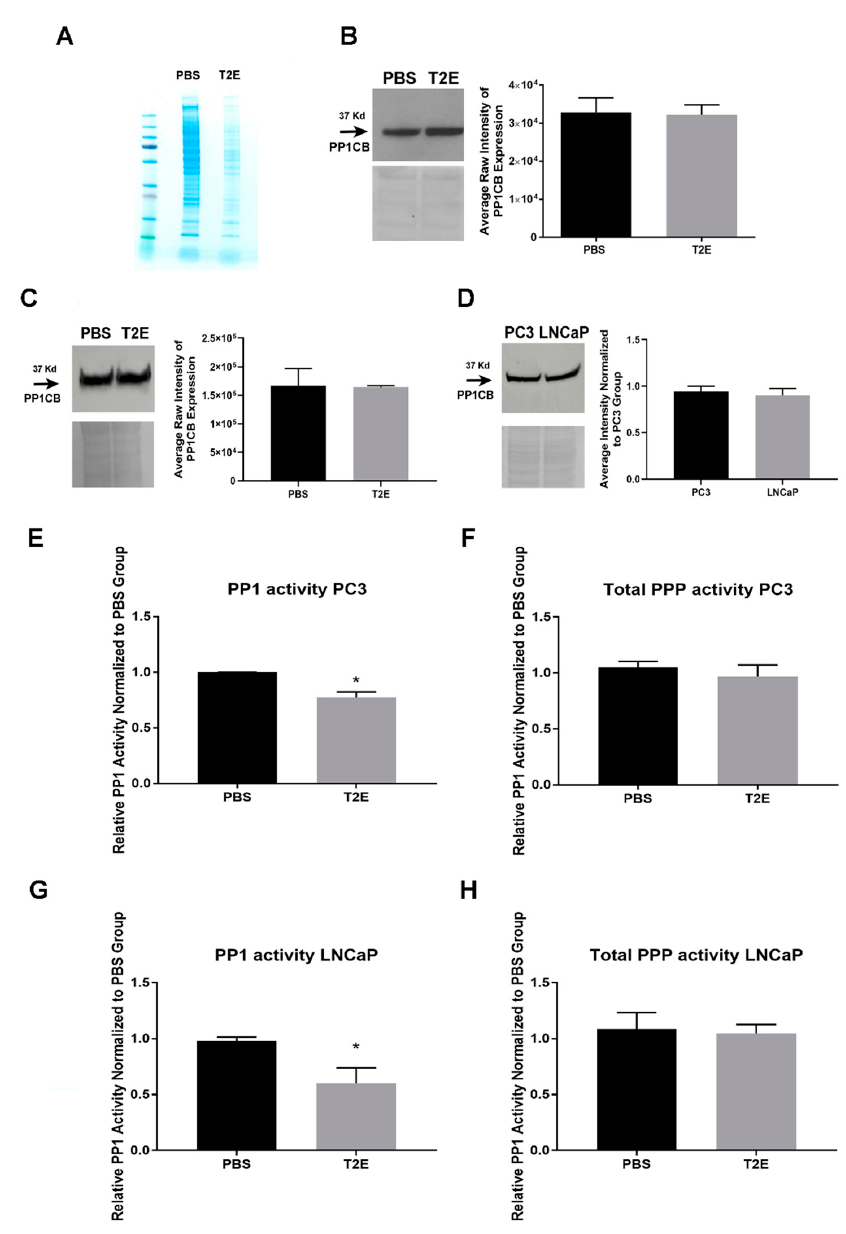
Figure 4. Identification of MnTE-2-PyP-induced protein oxidation and PPPs activity